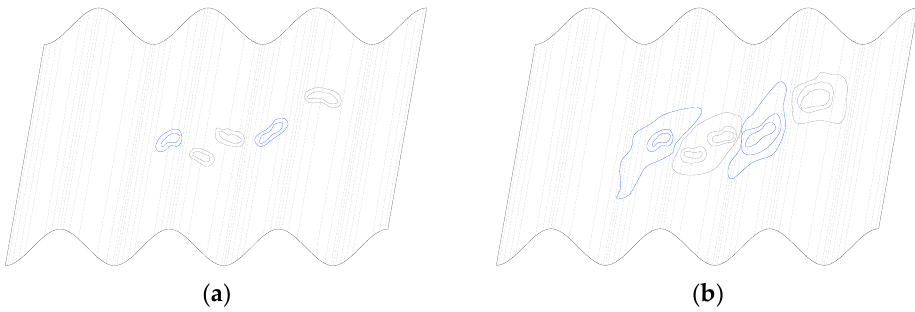
Figure 14. Process of loss of stability of the sinusoidal web: ( a ) formation of foci of local loss of stability and ( b ) formation of changes of direction.